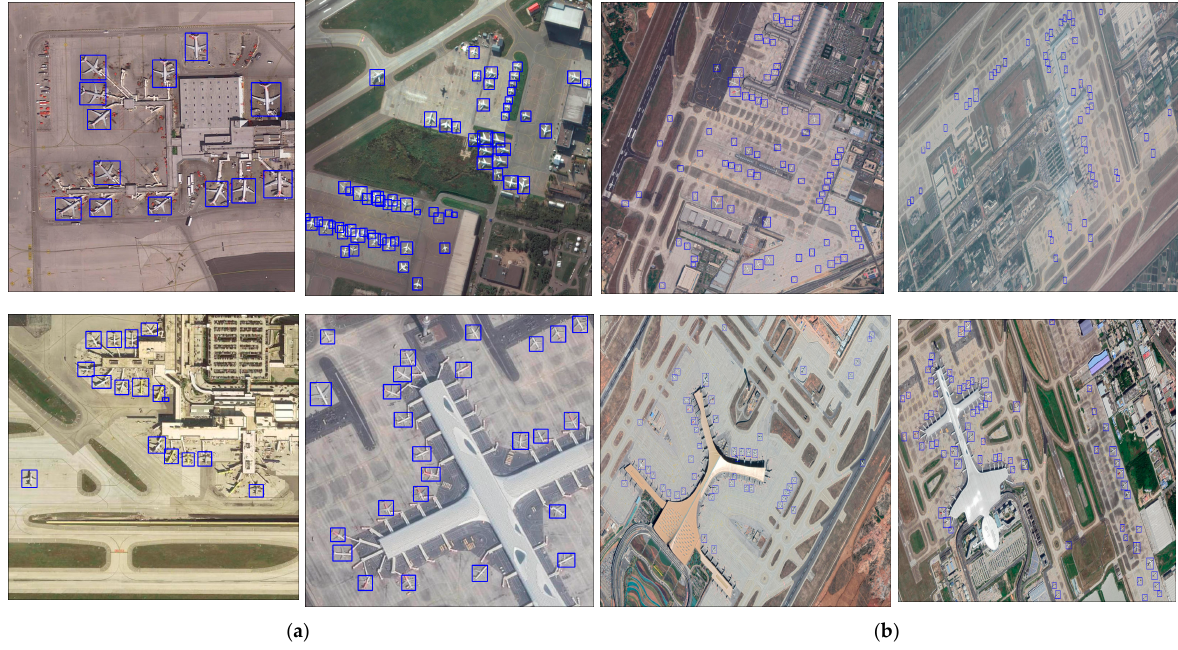
Figure 7. Results on different datasets. ( a ) Results on Dataset II. ( b ) Results on Dataset III.